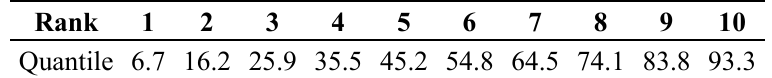
Table 2. Rank and theoretical sample quantiles at a sample size of 10